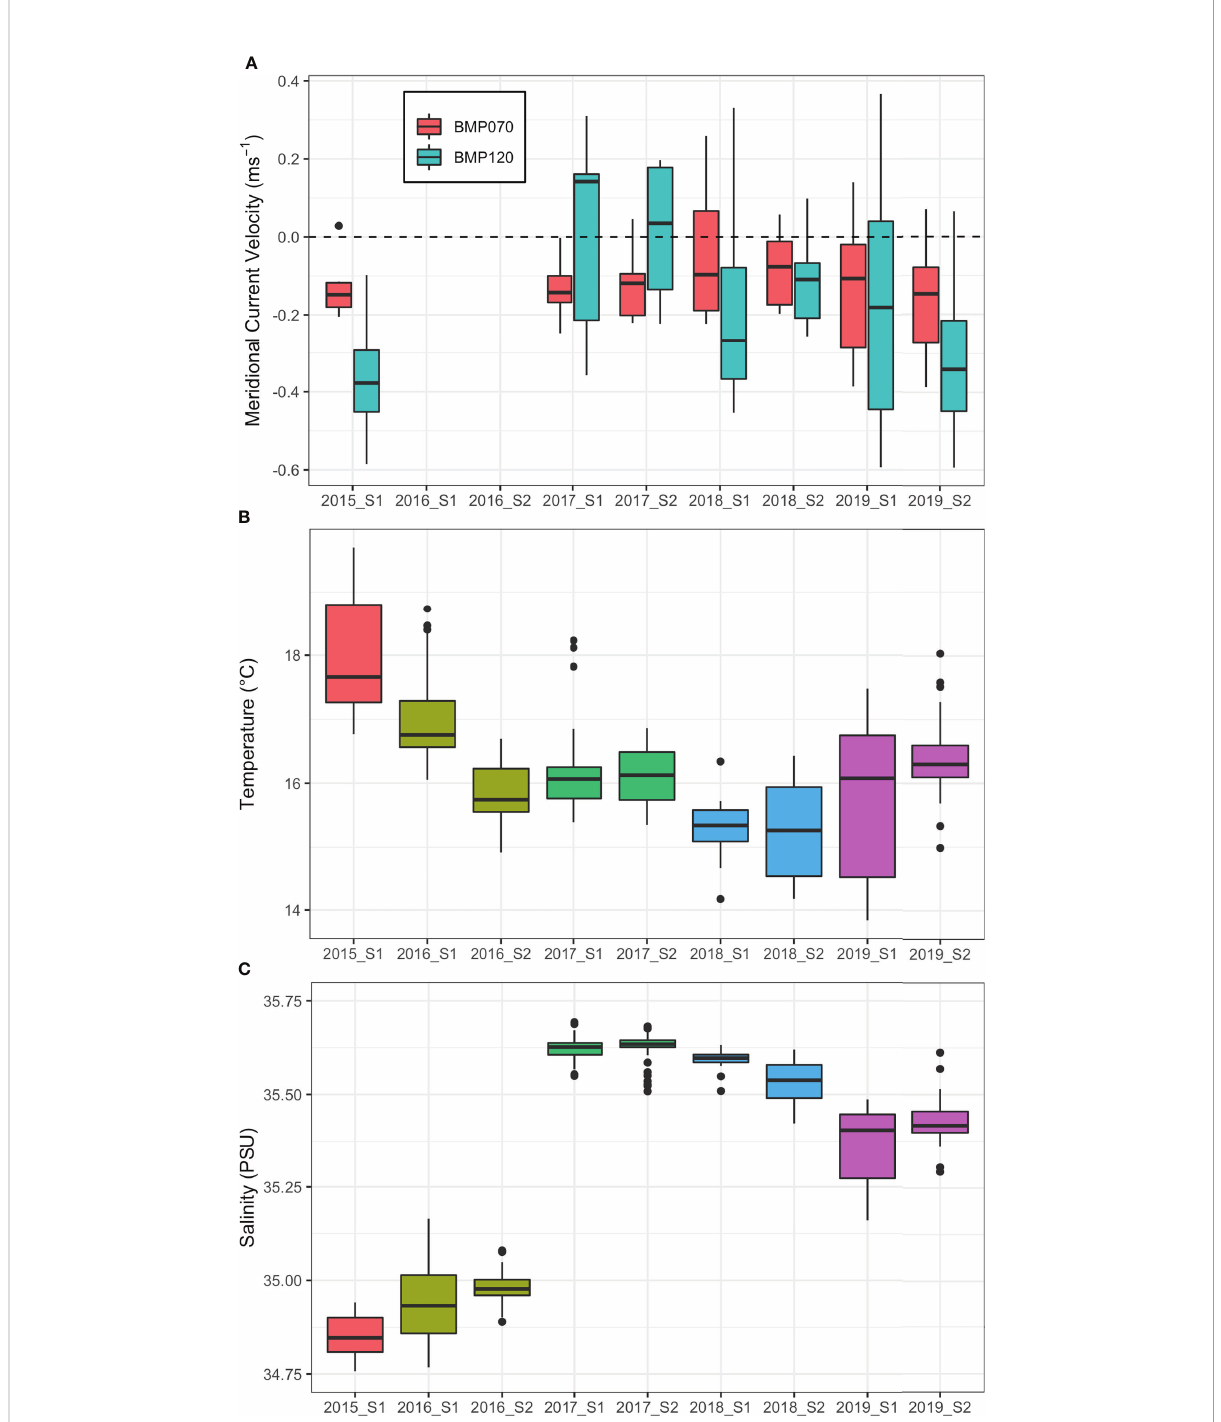
FIGURE 3 (A) Box plots of the daily mean meridional (north/south) current velocity measured over each of the survey periods from the moorings BMP070 (70 m isobath) and BMP120 (120 m isobath). Due to an equipment failure, no data was recorded for surveys 2016 S1 and 2016 S2. (B) Boxplots of mean temperature and (C) salinity for each of the CTD casts during each survey. As multiple surveys were conducted in a given calendar year, surveys have been coloured by year to highlight interannual